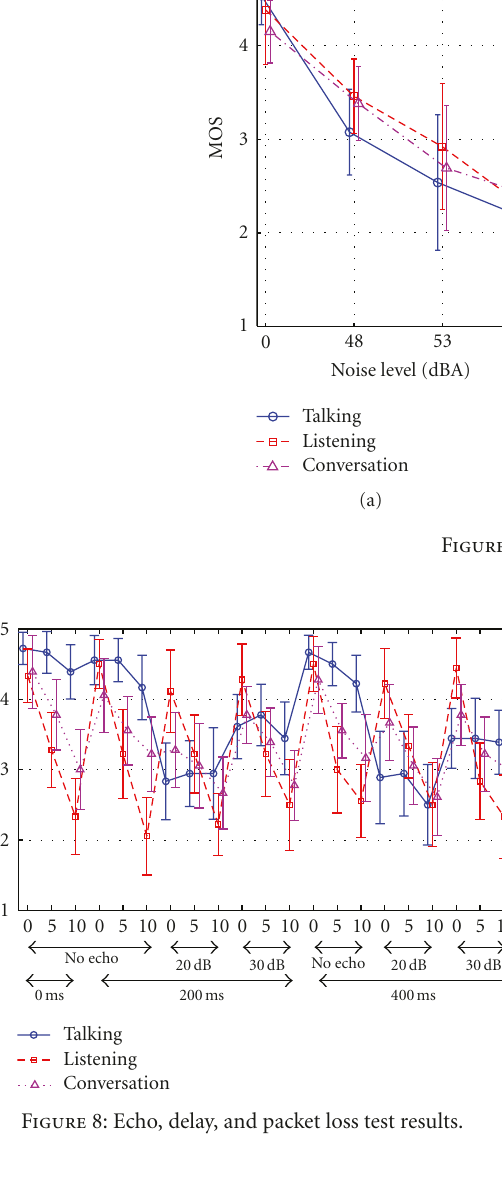
subjects (9 females and 9 males) participated in this test. They communicated with ISDN handsets (G.711